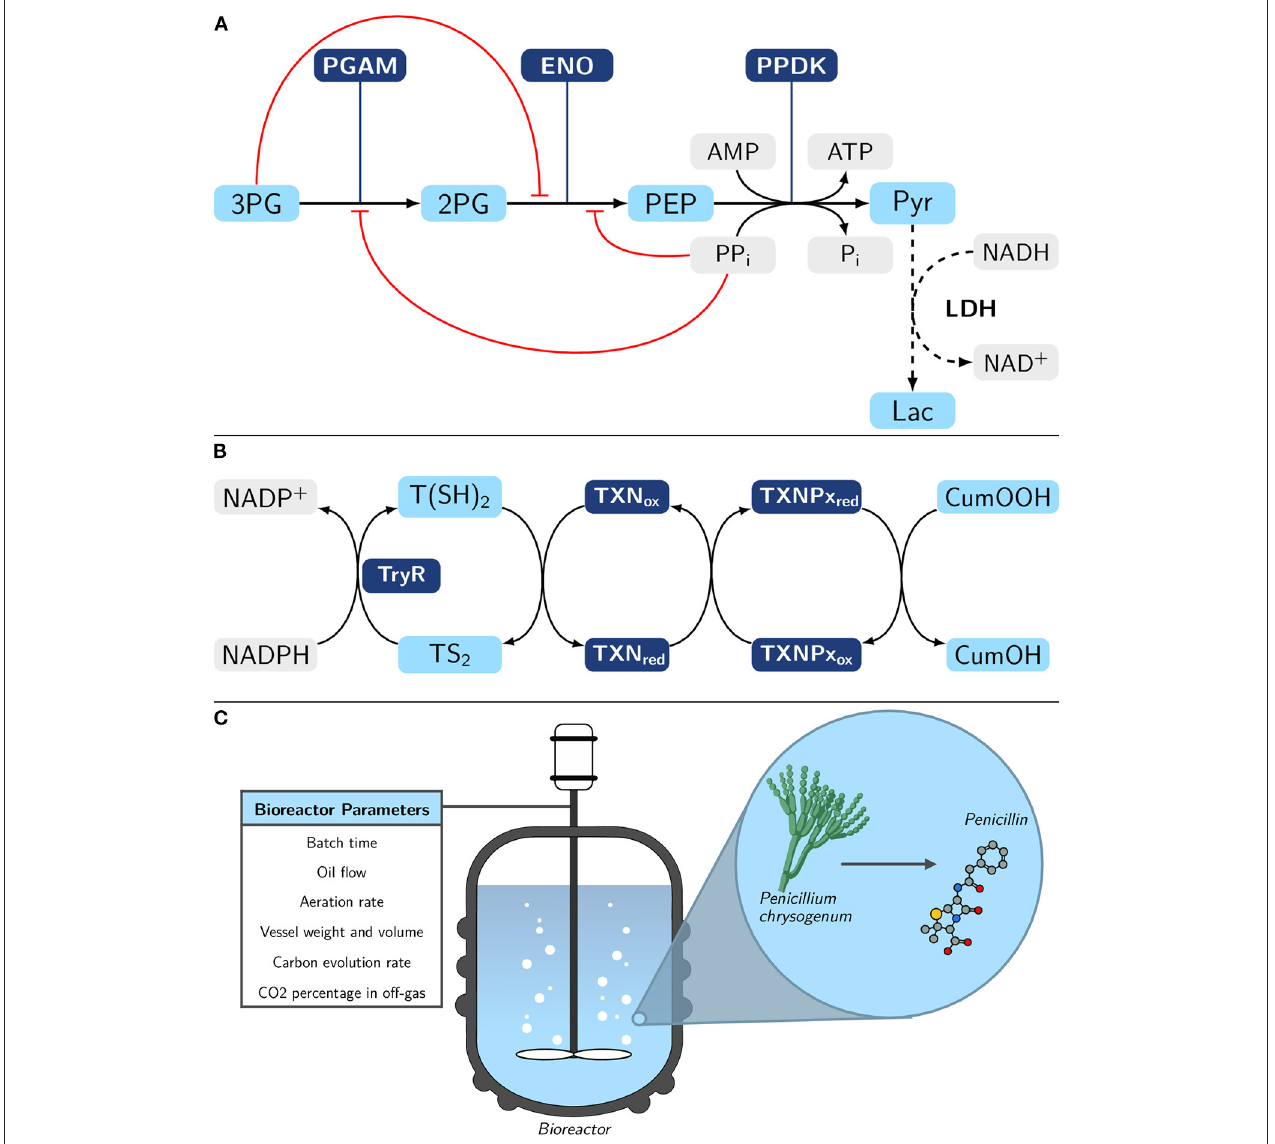
FIGURE 3 | Overview of the three metabolic pathways modeled with machine learning methods. (A) Lower part of E. histolytica glycolysis pathway with pyruvate (Pyr) formation from 3- phosphoglycerate (3PG). The L-lactate (Lac) formation (dashed lines) is not part of the natural pathway; however, lactate dehydrogenase (LDH) has been added in order to experimentally follow the final flux and establish a quasi-steady-state to Lac (Moreno-Sánchez et al., 2008). Metabolite inhibitions are represented in red. PGAM, 3-phosphoglycerate mutase; 2PG, 2-phosphoglycerate; ENO, enolase; PEP, phosphoenolpyruvate; PPDK, pyruvate phosphate dikinase. (B) Tryparedoxin-dependent hydroperoxide detoxification pathway in Trypanosoma cruzi (González-Chávez et al., 2015). Reduction of cumene hydroperoxide (CumOOH) is assessed here. TryR, trypanothione reductase; T(SH) 2 , trypanothione; TS 2 , trypanothione disulfide; TXN ox / red , oxidized/reduced tryparedoxin; TXNPx ox / red , oxidized/reduced tryparedoxin peroxidase. (C) Simplified representation of the industrial-scale penicillin fermentation process of Penicillium chrysogenum . The bioreactor parameters represented here are those that will be of interest in this study. See a more detailed scheme in the work of Goldrick et al. (2015). Experimental details for (A,B) are provided in section Material and